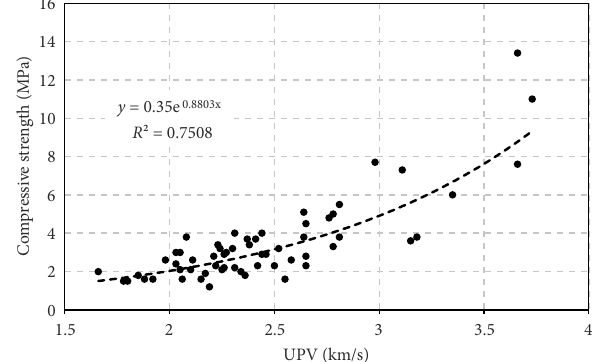
Figure 8. The relationship between the compressive strength UPV